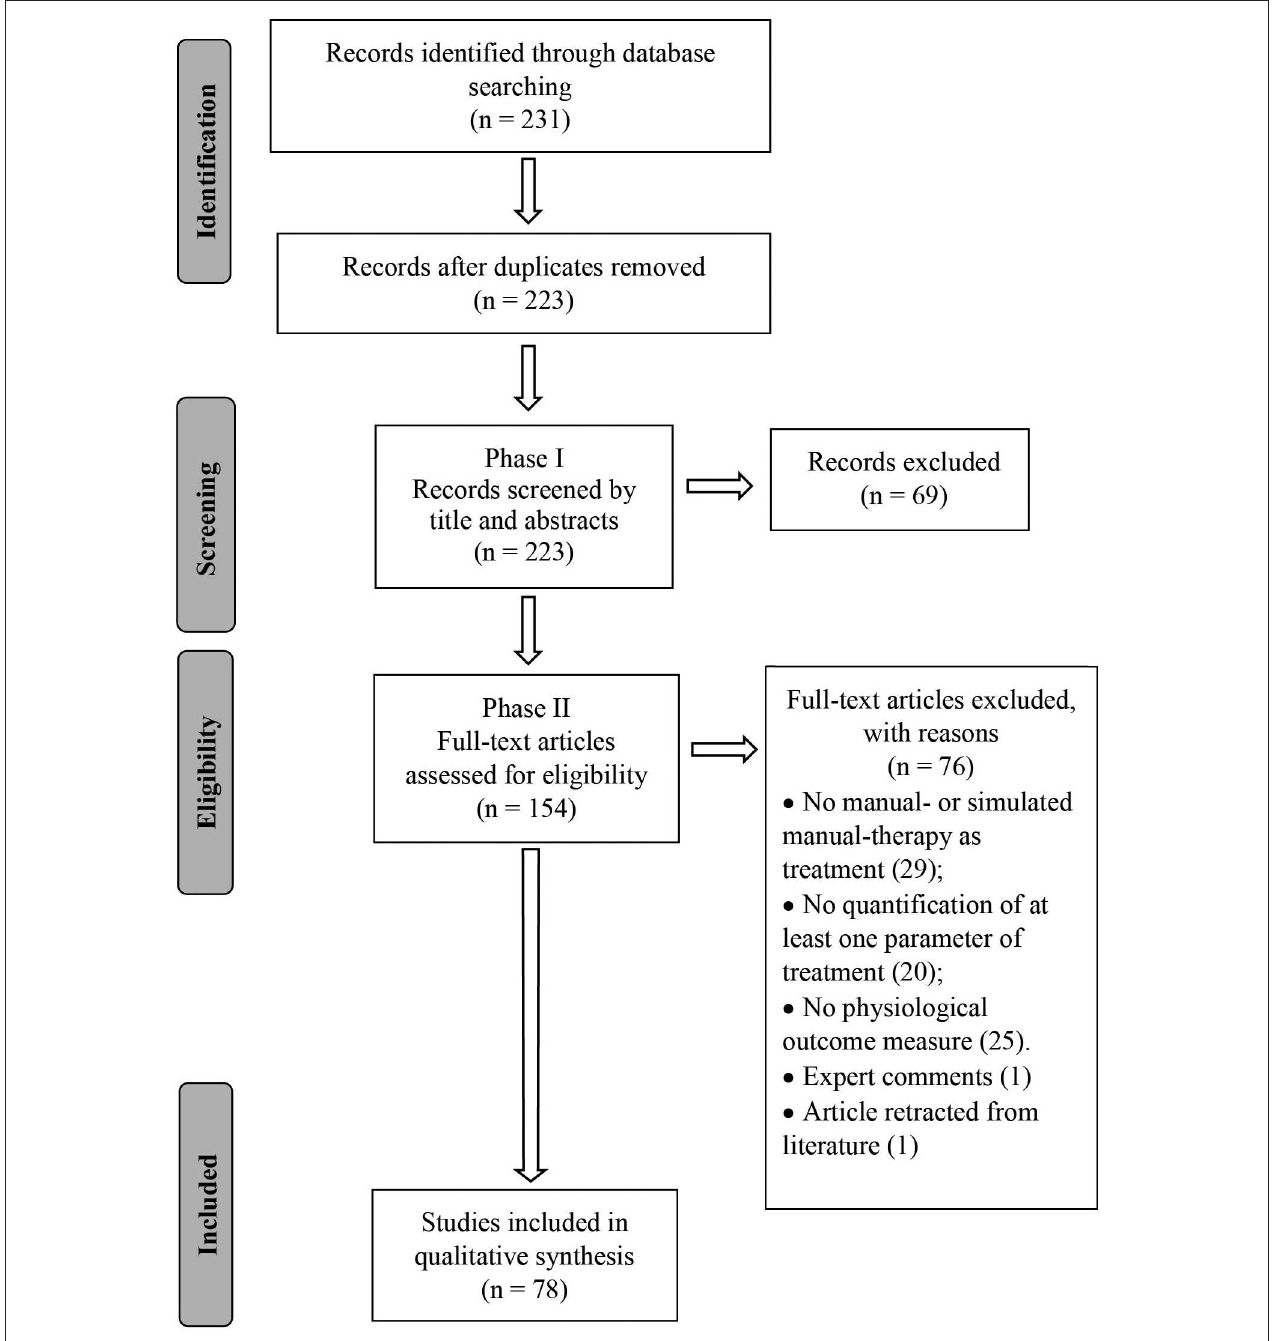
FIGURE 1 | Flowchart